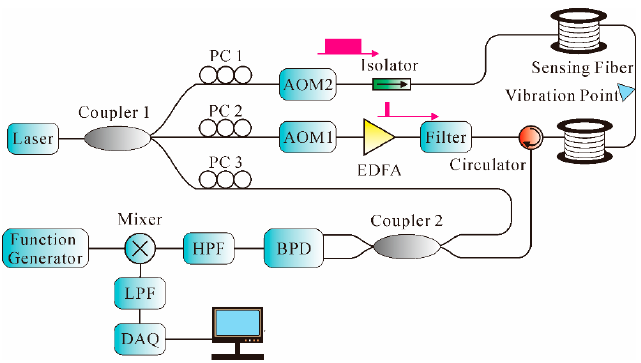
Figure 15. Experimental setup of distributed vibration sensing system merging the MZI and Φ -OTDR systems using modulated time-difference pulses , adapted from He et al. [141] .